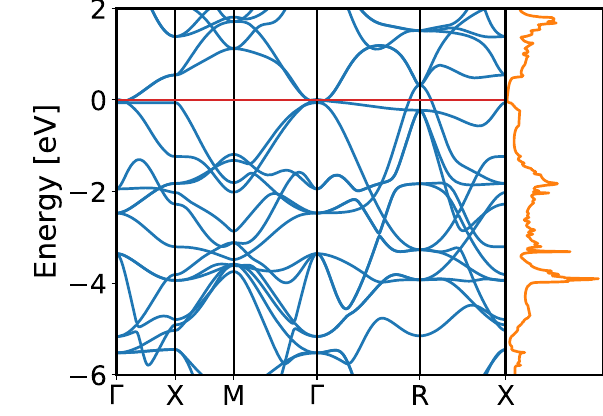
Fig. 2 Calculated band structure (left) and total density-of-states (right) for PtHBe 3 . The red line represents the Fermi level.